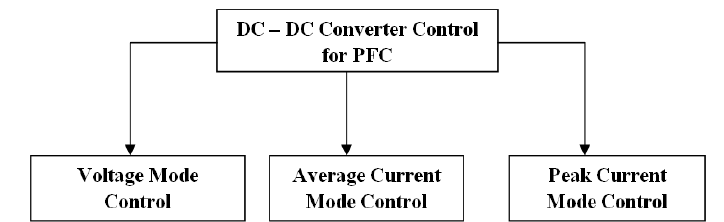
Figure 1. DC–DC converter control for PFC.